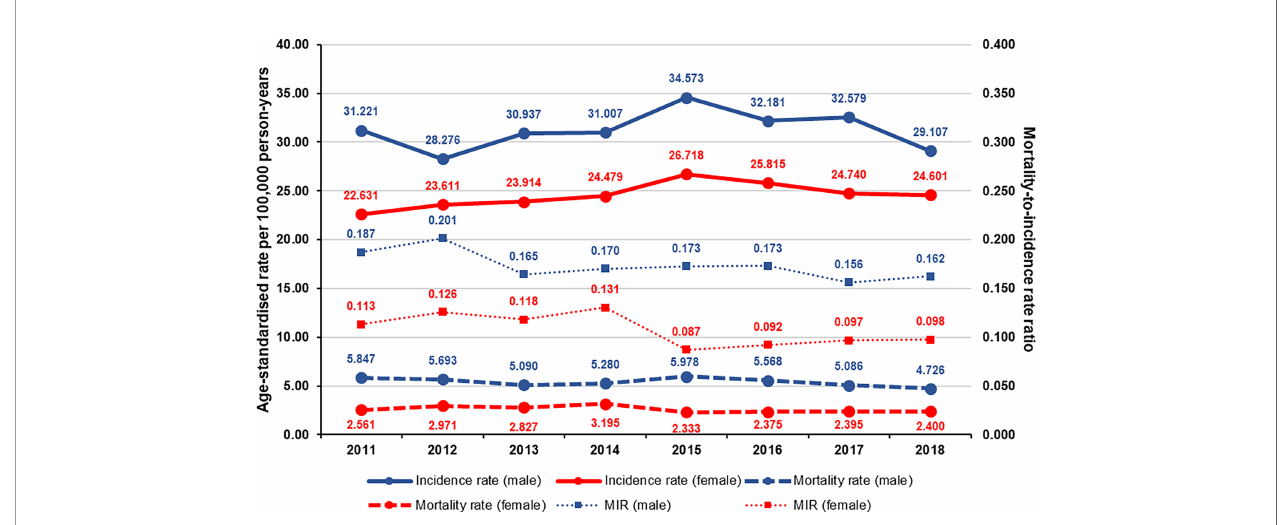
FIGURE 2 | Age-standardized incidence rates, mortality rates, and mortality-to-incidence ratios of melanoma per sex in Hungary between 2011 and 2018 (per 100,000 person-years, using ESP